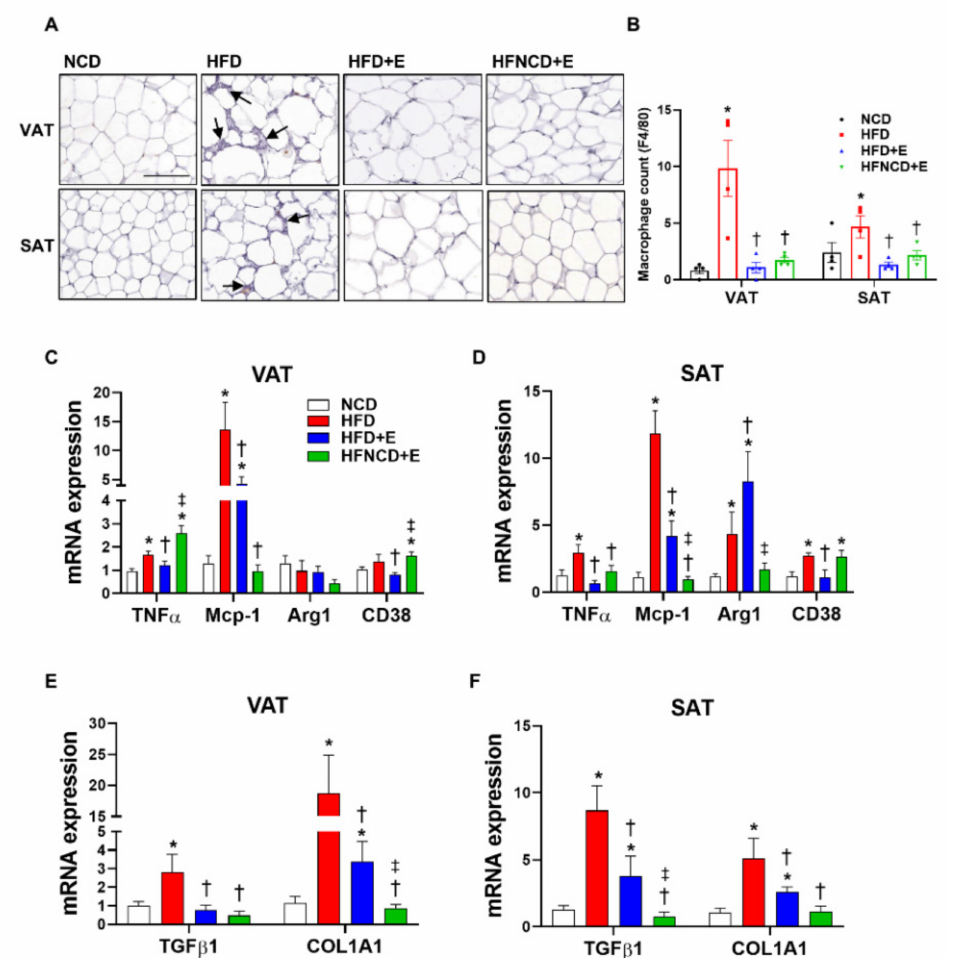
Figure 3. Exercise and diet ameliorate HFD-induced inflammation and fibrosis in adipose tis- sue. ( A , B ) Adipose tissues were stained with F4/80 and positive cells were counted as infiltrated macrophages (arrows indicate macrophages, scale bar indicates 100 µ m). Inflammatory gene expres- sion ( C , D ) and fibrosis markers ( E , F ) were measured in visceral and subcutaneous adipose tissues by real-time PCR. The quantifications were normalized to the 18S rRNA level for each target. Values are presented as mean ± SEM. * p < 0.05 compared with NCD, † p < 0.05 compared with HFD, ‡ p < 0.05 compared with